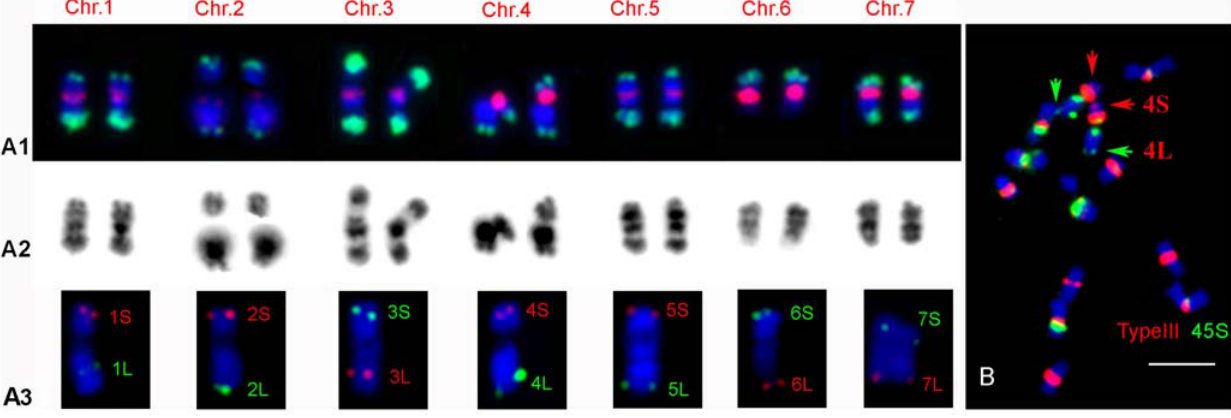
Figure 3. Integration of the seven linkage groups of cucumber with individual chromosomes. (A1) Distribution of Type I/II (green) and Type III (red) repeats on cucumber chromosomes. (A2) DAPI staining was converted to black and white images. (A3) Localization of chromosome- specific fosmid clones on both arms of individual chromosomes, genetic location of arm-specific fosmid clones are indicated in Figure 2. (B) Localization of fosmids 4S (red) and 4L (green) together with Type III (red) and 45S rDNA (green) repeats on the mitotic chromosomes. Bar=2.5 m m.